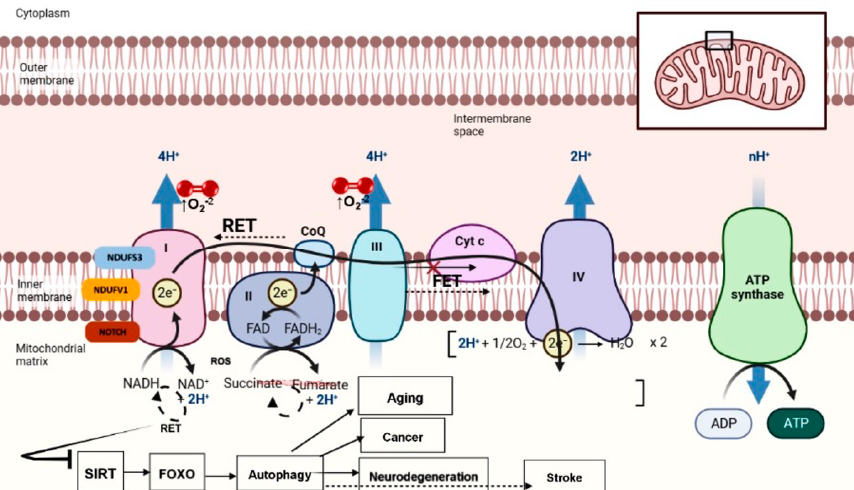
Figure 2. Diagram illustrating RET and RET-regulated NAD + -dependent sirtuin signaling pathway as a contributor and potential therapeutic target for aging, age-related diseases, and ischemic stroke. Lack of O 2 and accumulation of succinate as in ischemic stroke, or impairment of C-III, IV, or V as in aging and age-related diseases can lead to a slowdown of FET and acceleration of RET. In addition to damage by RET-generated ROS (RET-ROS), RET-induced drop of NAD + /NADH ratio can compromise the NAD + -dependent sirtuin-FOXO-autophagy signaling pathway and contribute to general aging, age-related diseases, including cancer and neurodegeneration, and stroke.